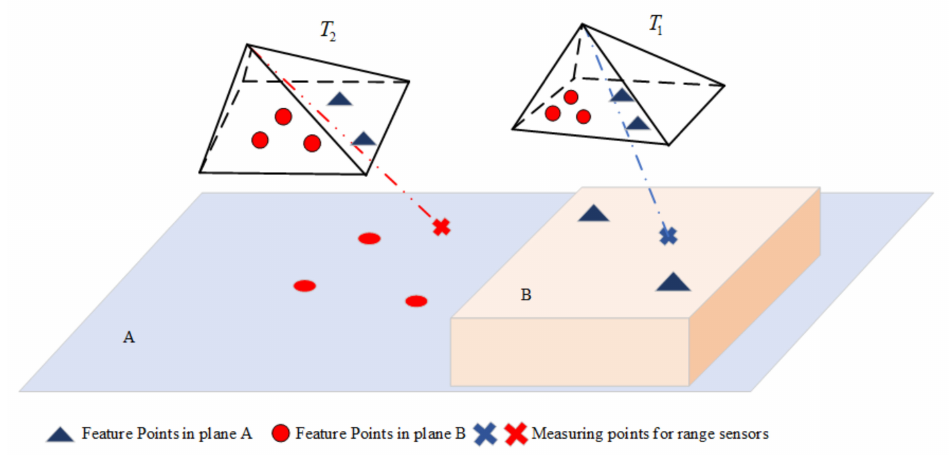
Figure 5. The feature point and range point are not in the same plane at the different moments of T 1 and T 2